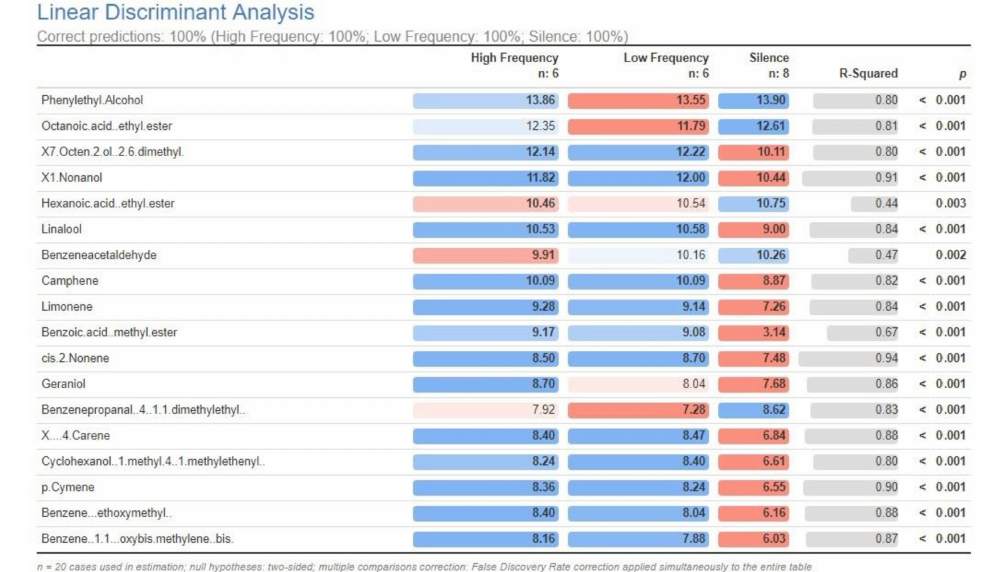
Figure A1. Accuracy of the LDA model tested using a LOOCV. The average log 10 (relative abundance) of each putatively identified compound for each sound stimulus is shown. The R-squared column shows the proportion of variance within each row that is explained by the categories. As such, cis 2 Nonene is the best